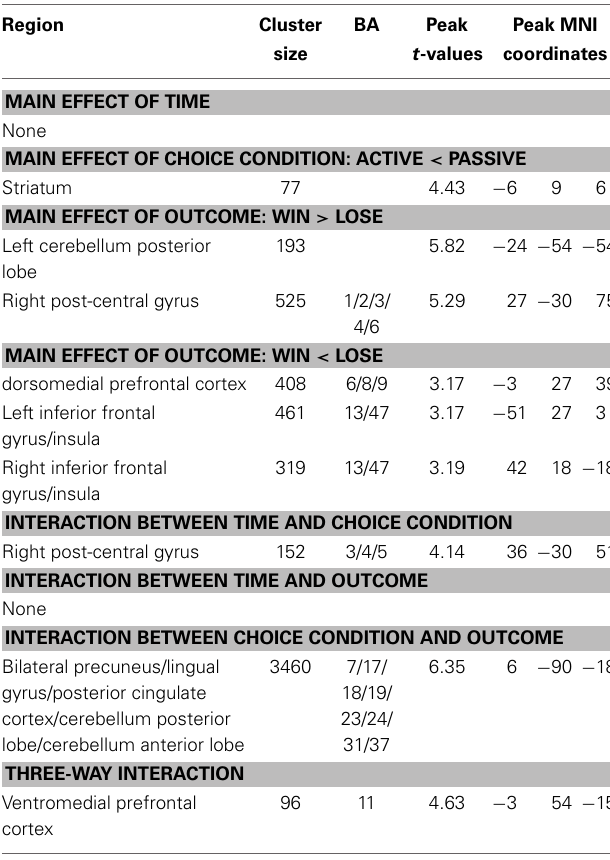
Table 4 | The result of outcome-related brain regions identified in the post-hoc t